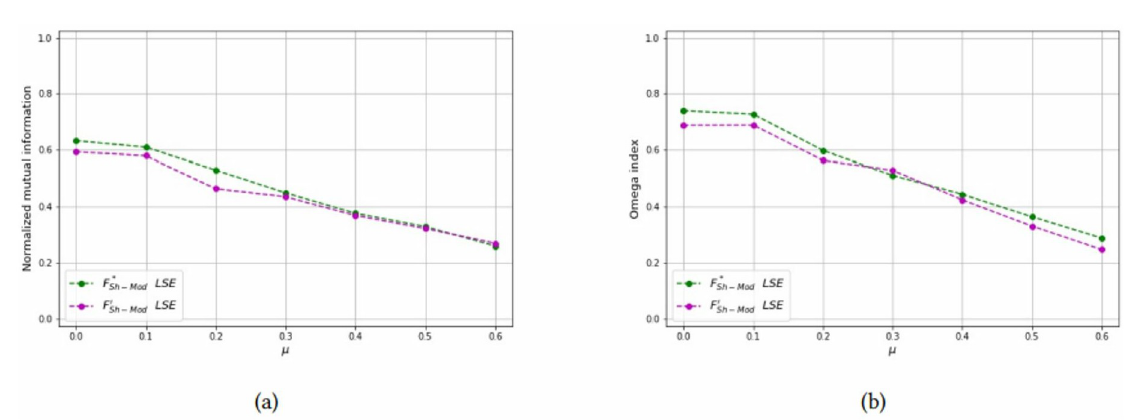
Fig 20. Test results on overlapping communities, parameters N = 500, n c = 25, p = 2, μ o = 0.6, N o = 20. (a) Average NMI for each solution method, (b) Average Omega for each solution